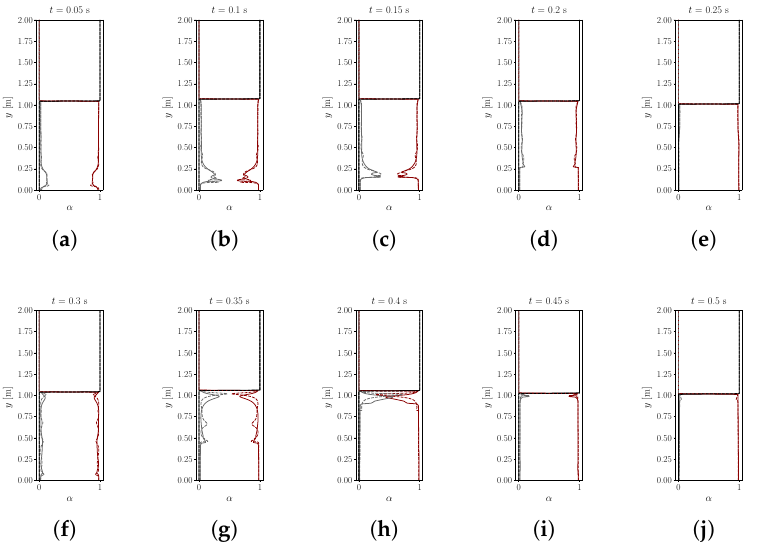
Figure 14. Temporal evolution of the void fraction profiles along the y-axis for ( a – j ) t = 0.05 s to t = 0.5 s. Grid A: